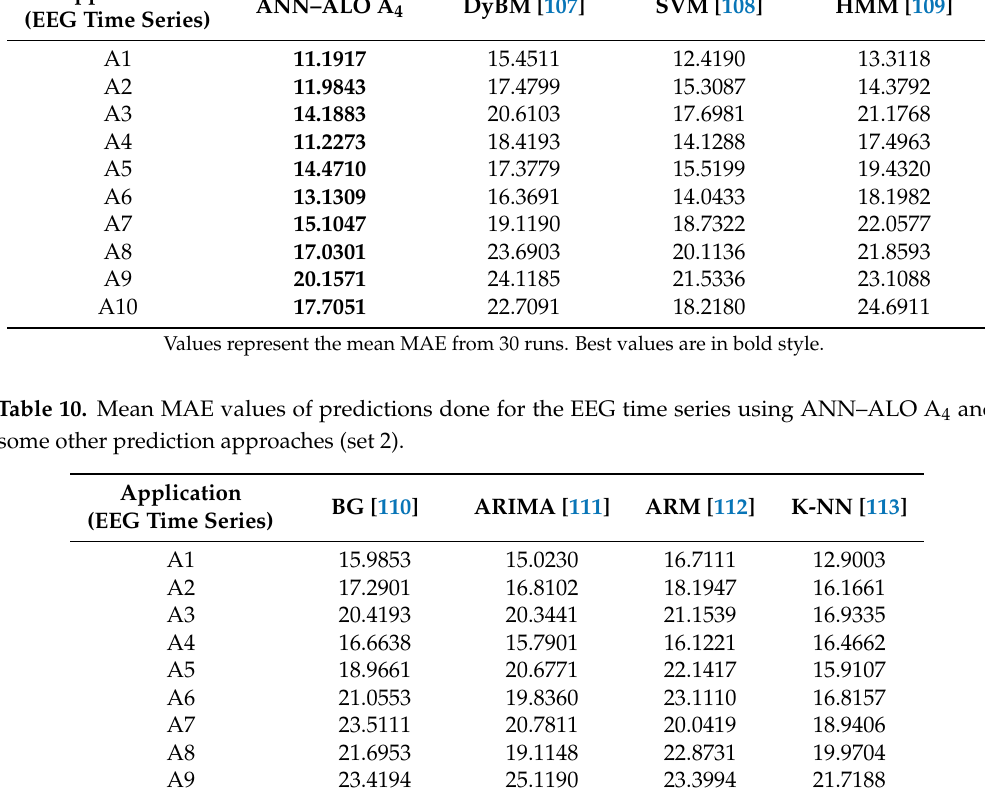
Table 9. Mean MAE values of predictions done for the EEG time series using ANN–ALO A 4 and some other prediction approaches (set 1).